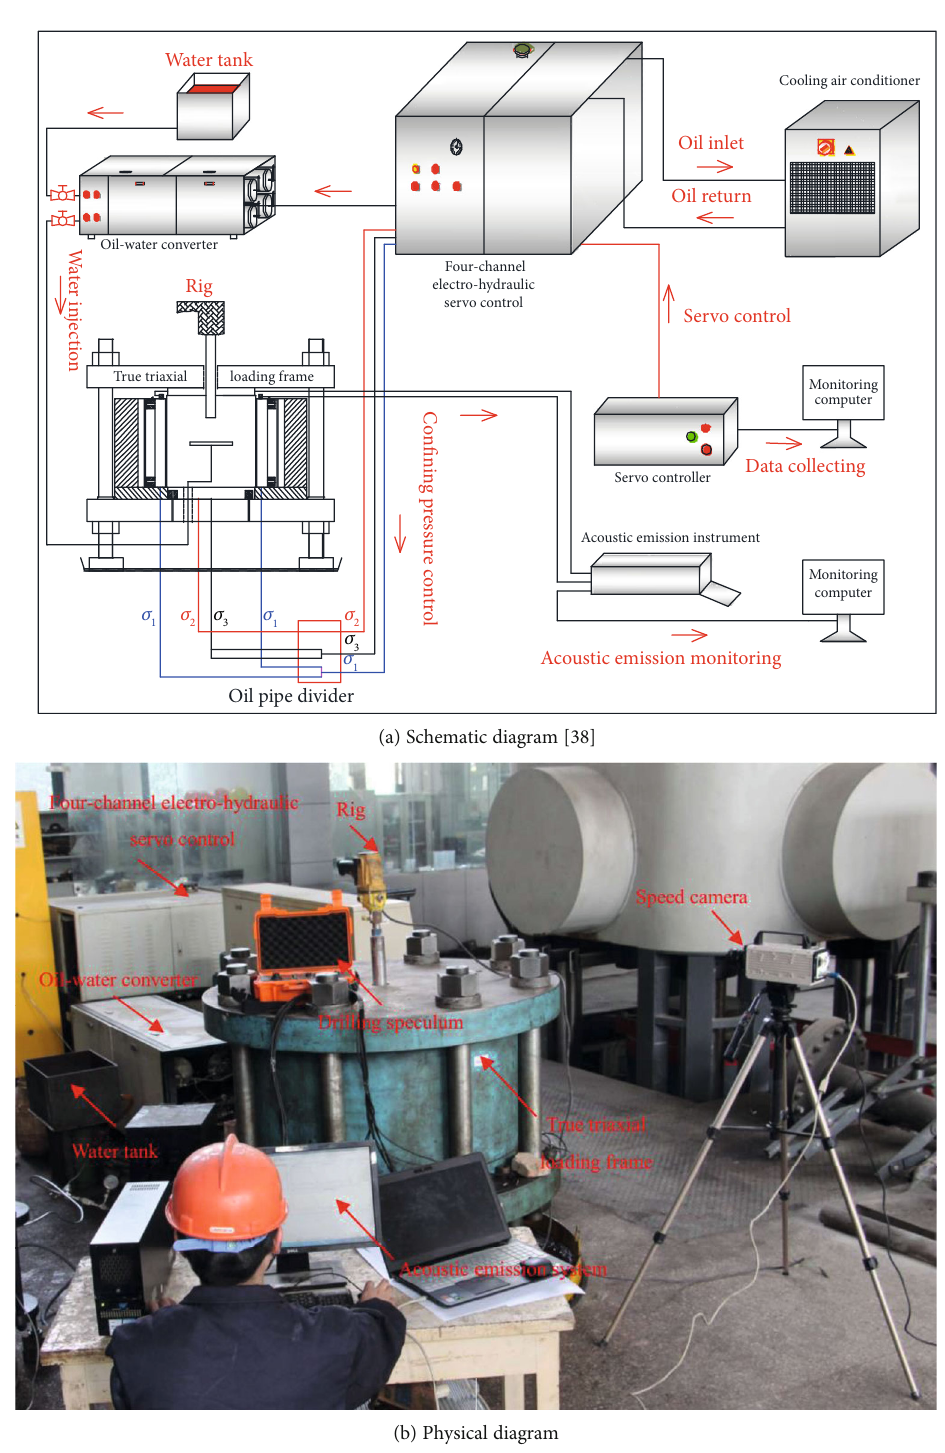
Figure 11: True triaxial water inrush experimental